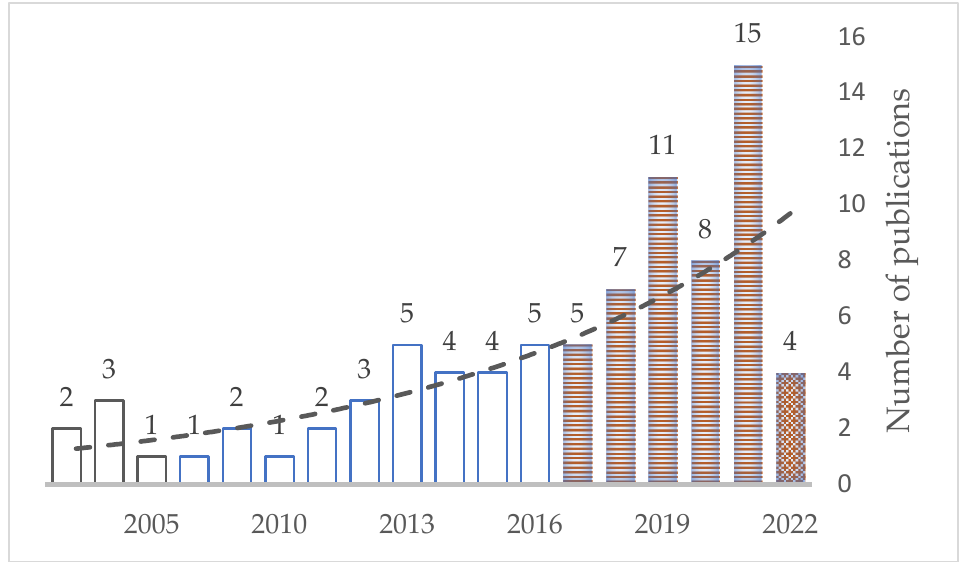
Figure 4. The number of selected studies and overall trend from 2000 to February 2022 .